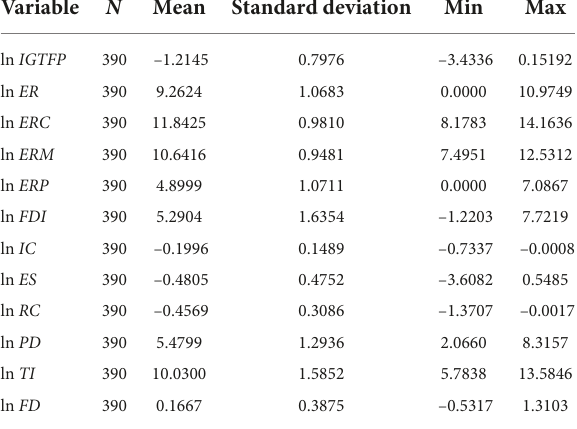
TABLE 1 Descriptive statistics of variables.